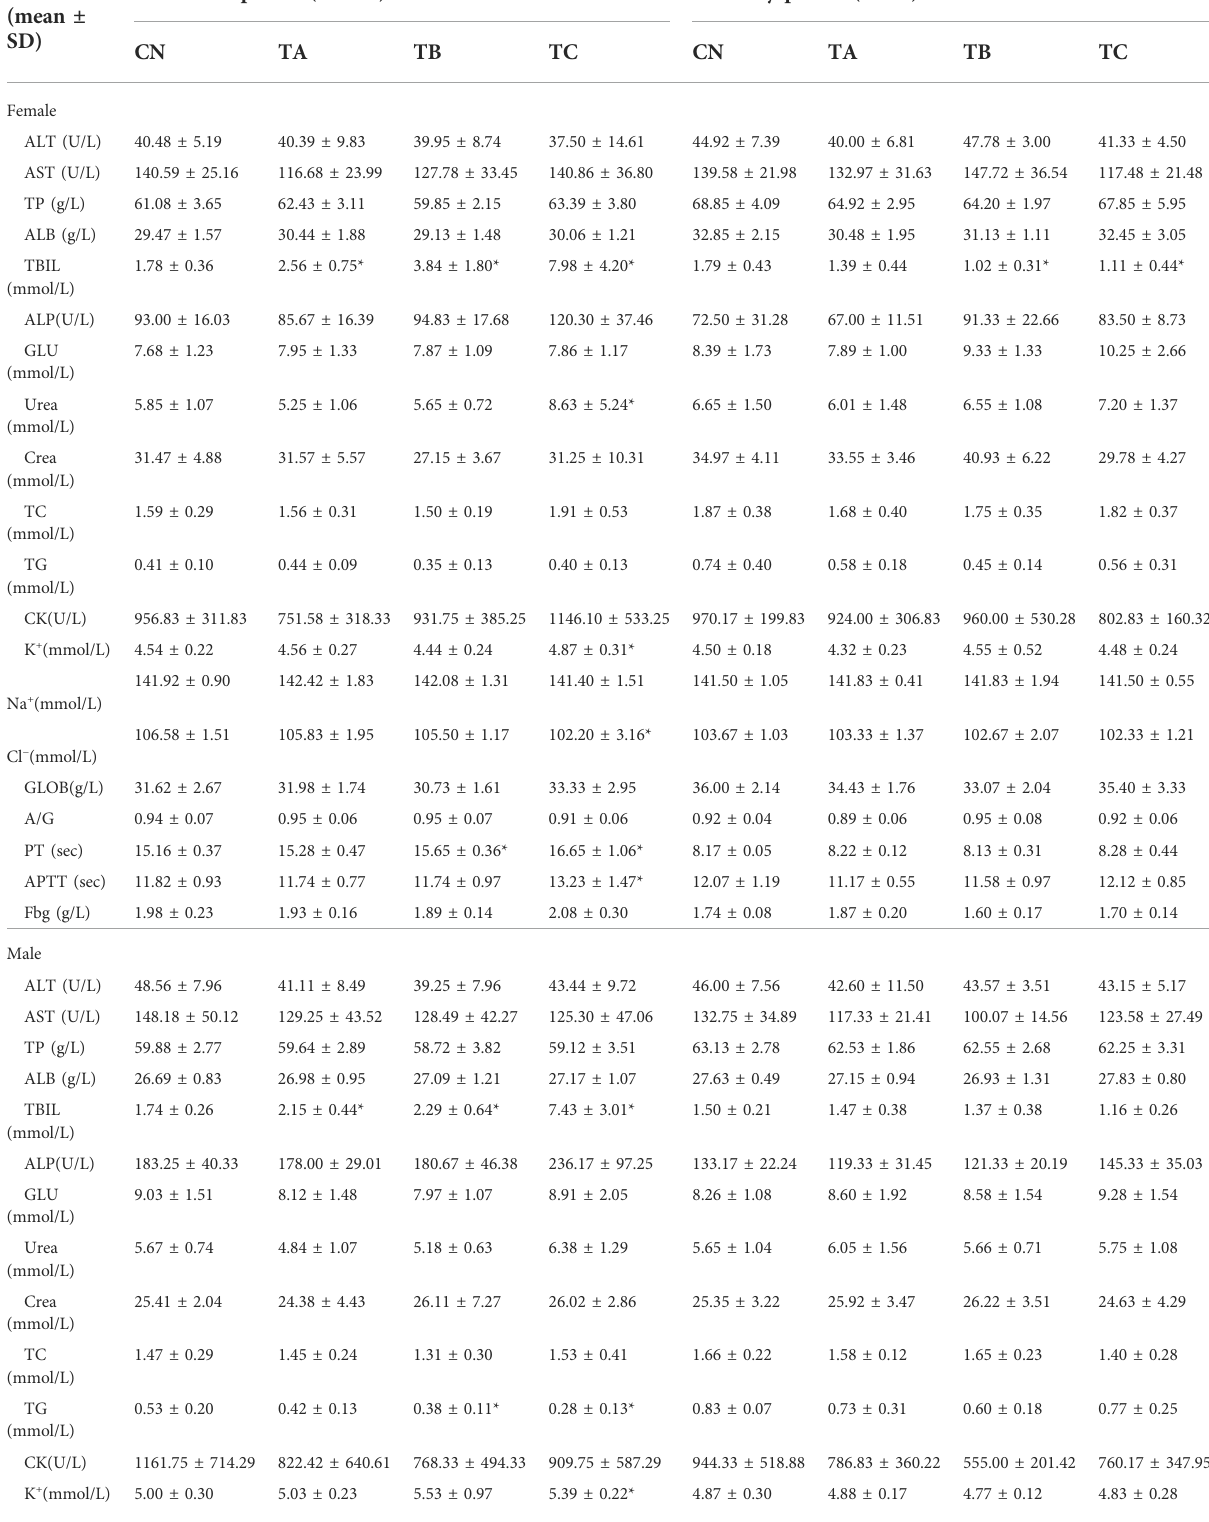
TABLE 3 Effect of QZZD on biochemical and coagulation parameters in the sub-chronic oral toxicity study. Parameter (mean